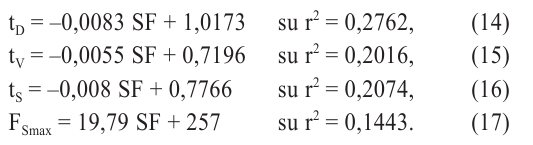
vienodai apkrovai jos grimzl ė didesn ė . Tolesniam nagrin ė jimui paliekame tik skirtingas valtis 8650 ir 8750. Remiantis tiesine regresine analize, ši ų val č i ų grimzl ė s T (determinacijos koef. r 2 = 0,999), dr ė - kinamojo paviršiaus ploto S (determinacijos koef. r 2 > 0,997), vertikalaus supimo slopimo koe fi cient ų v (determinacijos koef. r 2 > 0,8) priklausomyb ė nuo val č i ų kompleks ų mas ė s m ir dr ė kinamo paviršiaus ploto S (determinacijos koef. r 2 > 0,997) priklauso- mumas nuo grimzl ė s T , aprašoma (10), (11), (12) ir (13) regresijos lygtimis, kuri ų koe fi cient ų reikšm ė s pateiktos 1 lentel ė